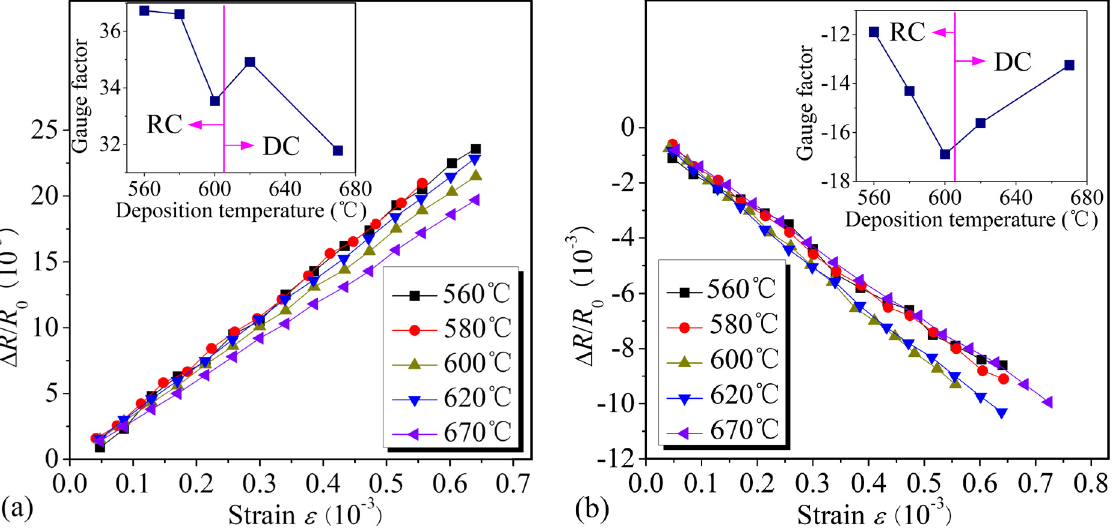
in longitudinal piezoresistors Figure 13. (a) Dependences of the resistance change Δ R / R 0 on strain ε with different deposition temperatures, and the longitudinal GF vs. deposition temperature. (b) Dependences of Δ R / R in transversal piezoresistors on strain ε with 0 different deposition temperatures, and the transversal GF vs. deposition